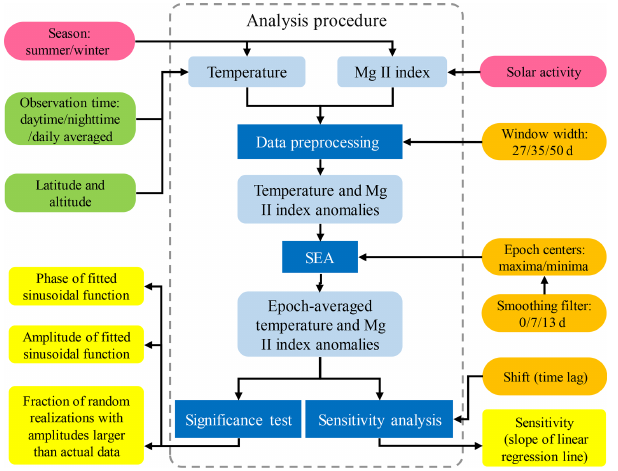
Figure 2. Flow chart of the analysis procedure and the input and output parameters.